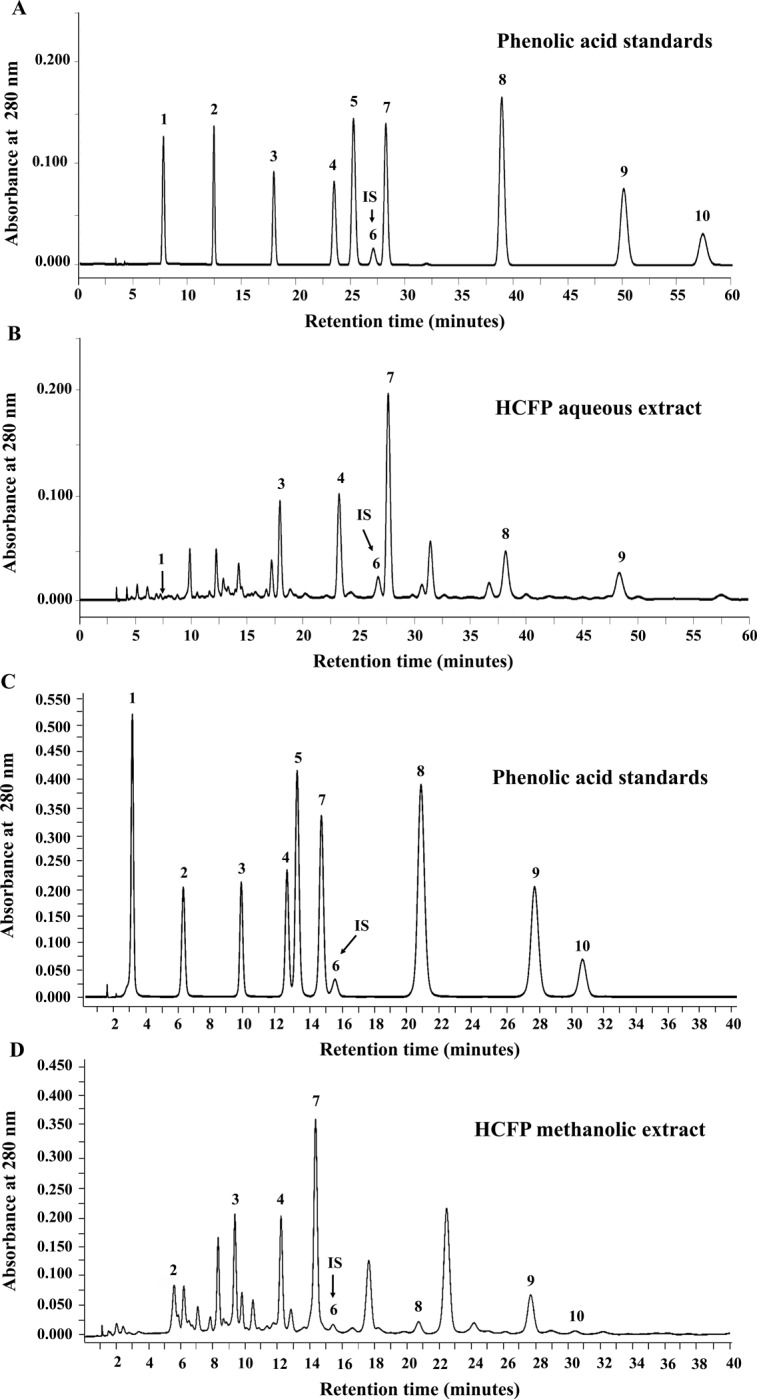
HPLC chromatograms of phenolic acid standards (A, C) and base hydrolyzed HCFP aqueous (B) and methanolic (D) extracts, where 1 = gallic acid, 2 = protocatechuic acid, 3 = p-hydroxybenzoic acid, 4 = vanillic acid, 5 = caffeic acid, 6 = m-hydroxybenzaldehyde, 7 = syringic acid, 8 = p-coumaric acid, 9 = ferulic acid and 10 = sinapinic acid. The m-hydroxybenzaldehyde was used as an internal standard (I.S.).